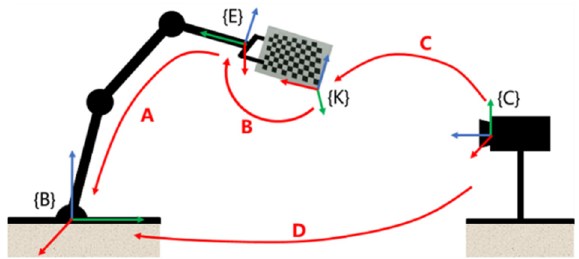
Figure 8. Schematic diagram of hand-eye calibration.